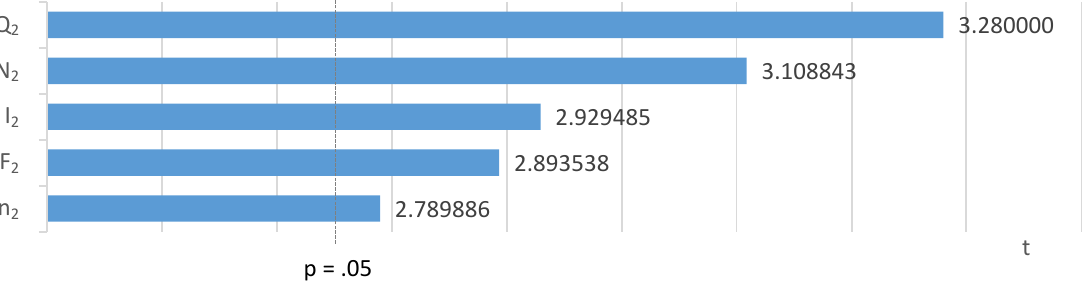
Figure 2. The significance of coefficients of the factors’ influence on the dynamics of GDP model (for